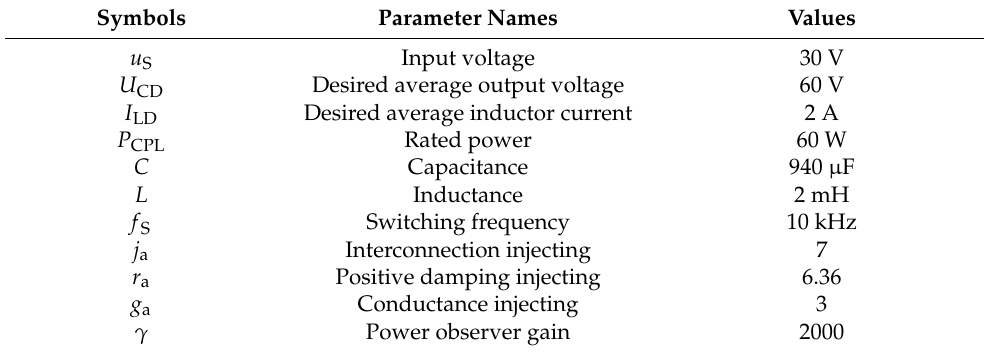
Table 1. Simulation parameters of DDBC.